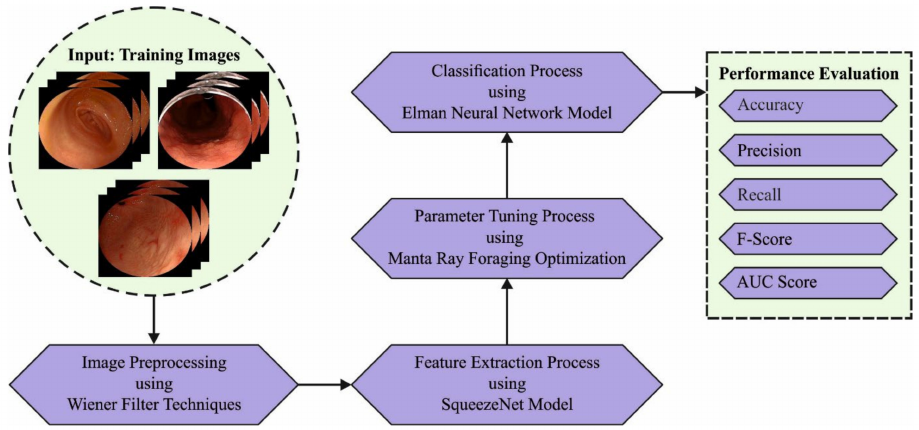
Figure 1. Block diagram of MRFOTL-GCDC